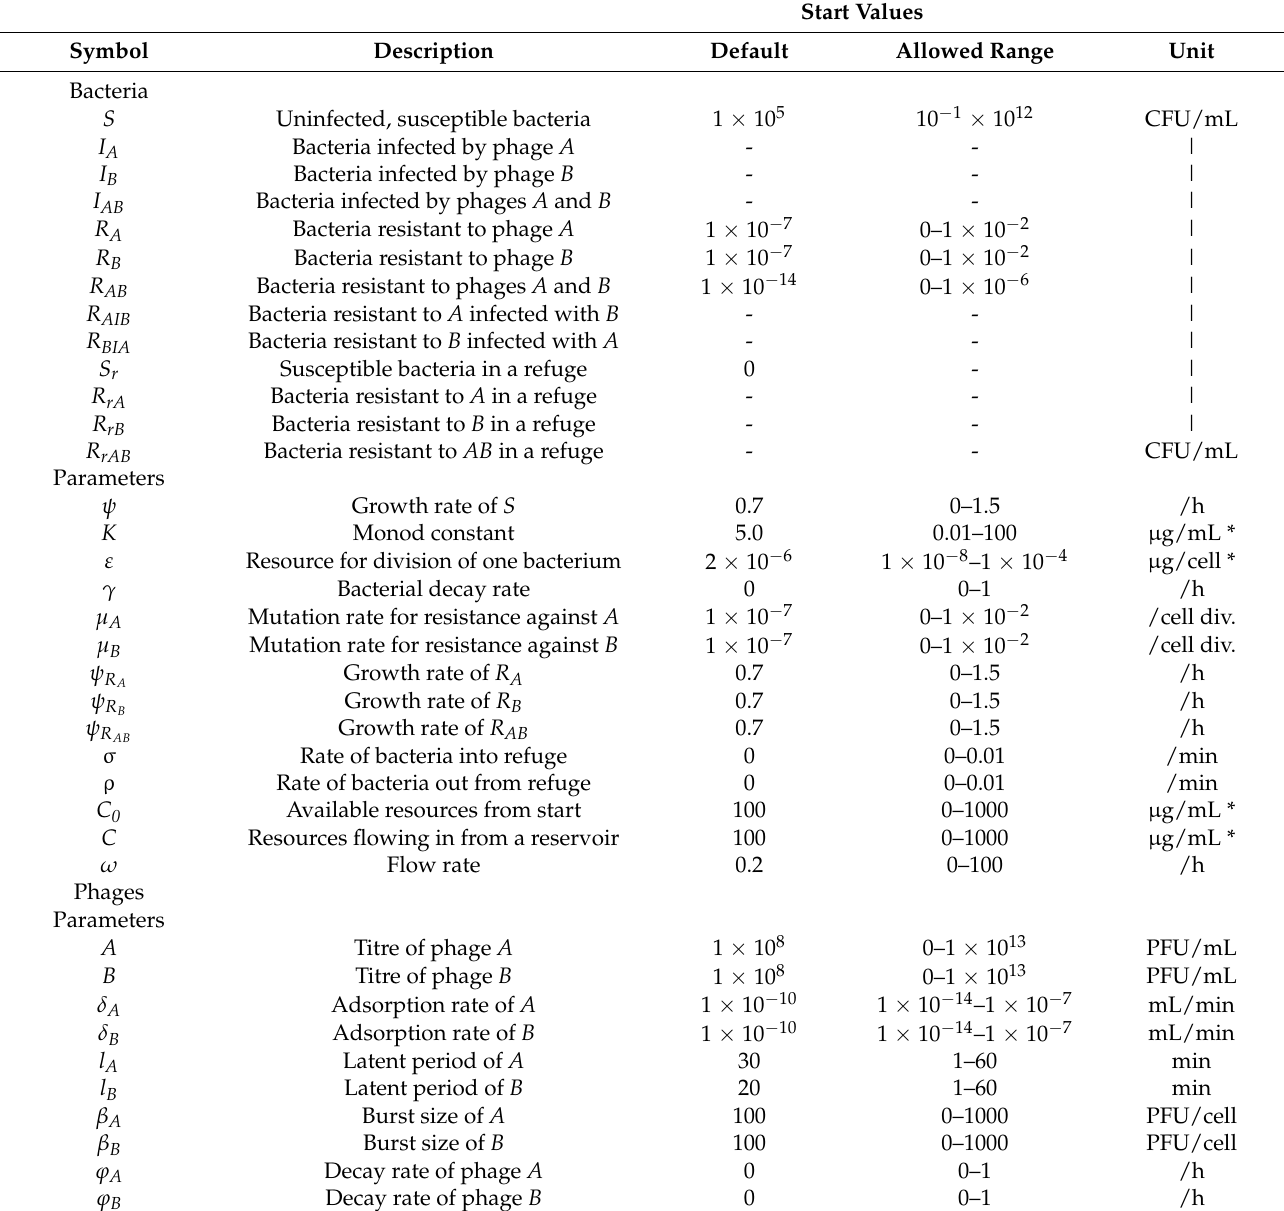
Table 1. Symbols and